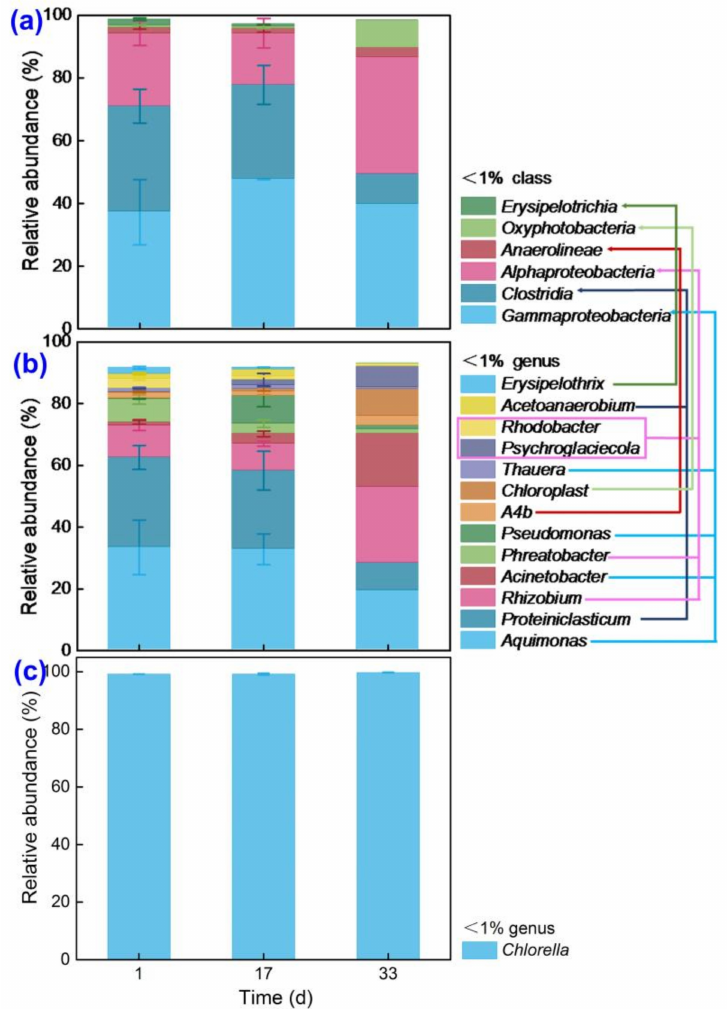
Figure 4. Distributions of prokaryotic diversity at class level ( a ) and genus level ( b ); eukaryotic diversity at genus level in microbial communities ( c ) on days 1, 17 and 33. Minority fractions of bacterial and algal communities indicated the sum of different classes and genus accounted for less than 1% of its total sequences in each